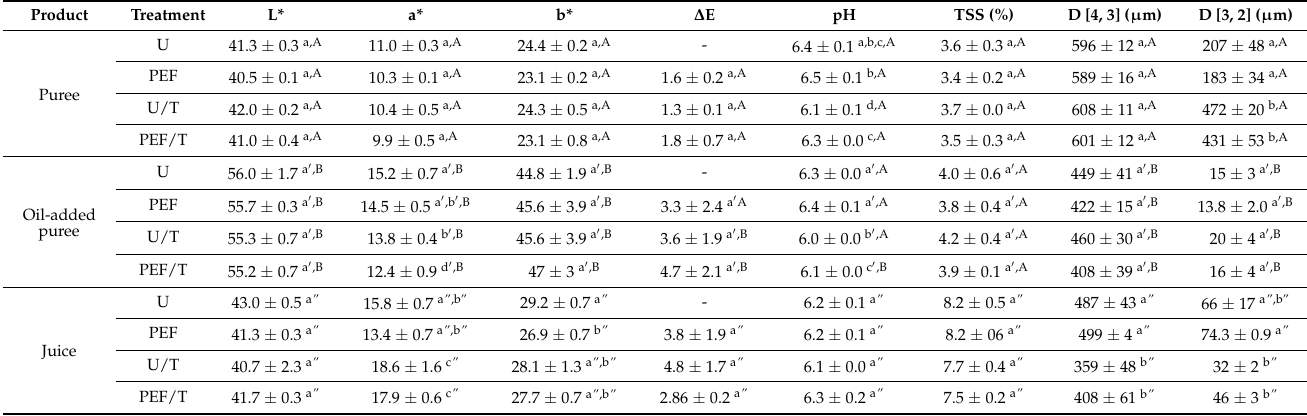
Values are means ± standard deviation. Different letters in the same column within the same product indicate significant ( p < 0.05) differences among treatments (puree: lowercase letters, puree with oil: lowercase letters (cid:48) , and juice: lowercase”). Different uppercase letters in the same row indicate significant differences between both purees. L*: lightness, a*: redness, b*: yellowness, ∆ E: total color difference, TSS: total soluble solids, D [4, 3]: mean volume diameter, and D [3, 2]: mean surface